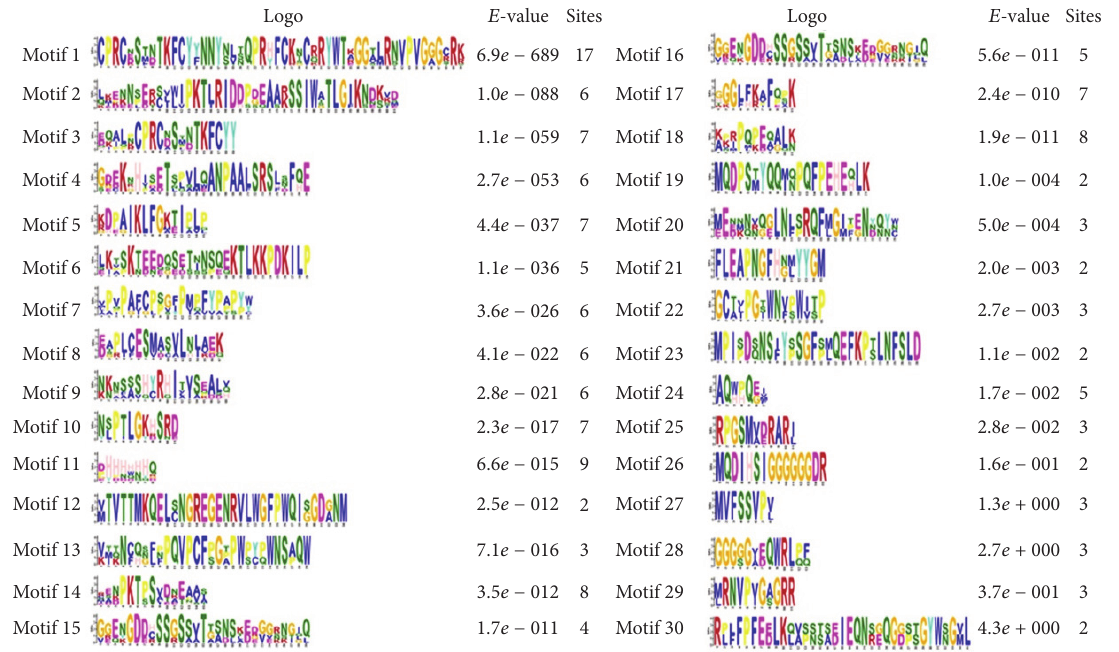
Figure 5: Sequence logos of Dof domains in C. sinensis . The overall height of the stack indicates the level of sequence conservation. Heights of residues within a stack indicate the relative frequency of each residue at that position.